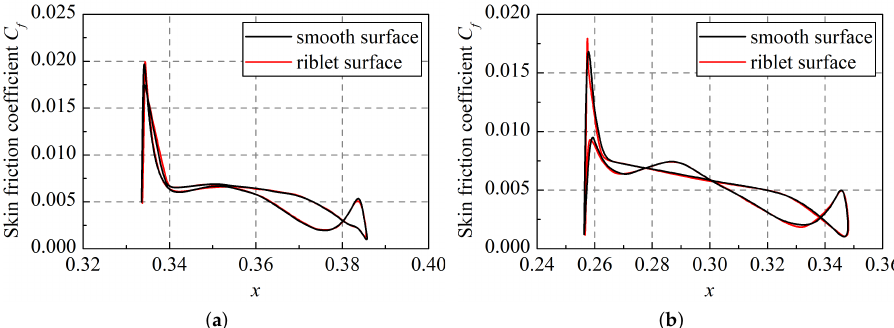
Figure 26. Distributions of skin friction coefficient at different cross-sections. ( a ) distribution of skin friction coefficient at cross-section A; ( b ) distribution of skin friction coefficient at cross-section